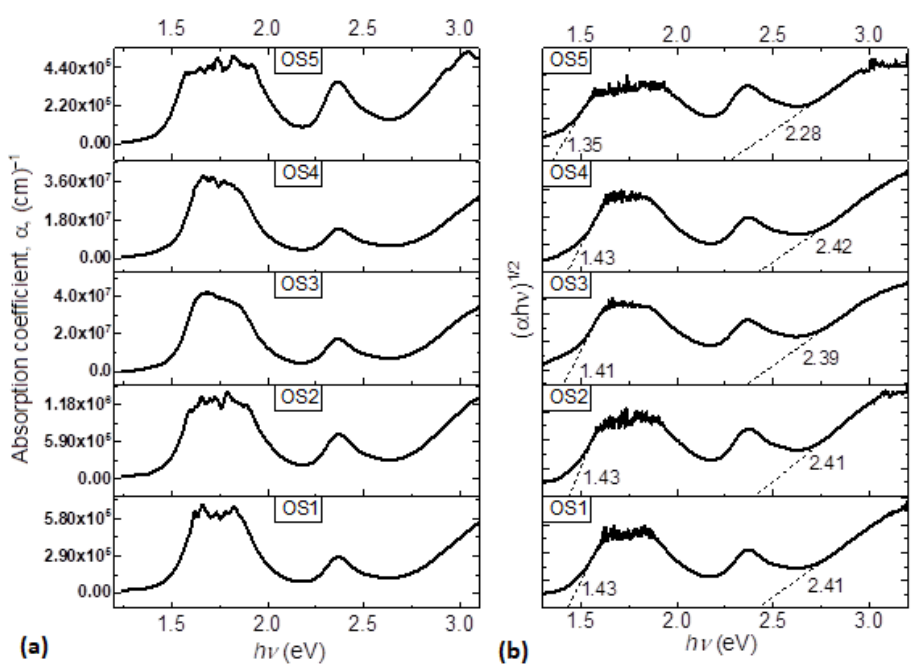
Figure 5. ( a ) Absorption coefficients, α, and ( b ) plots of ( α h ν ) 1/2 versus photon energy (hν) of the MnPcCl – chalcone films.